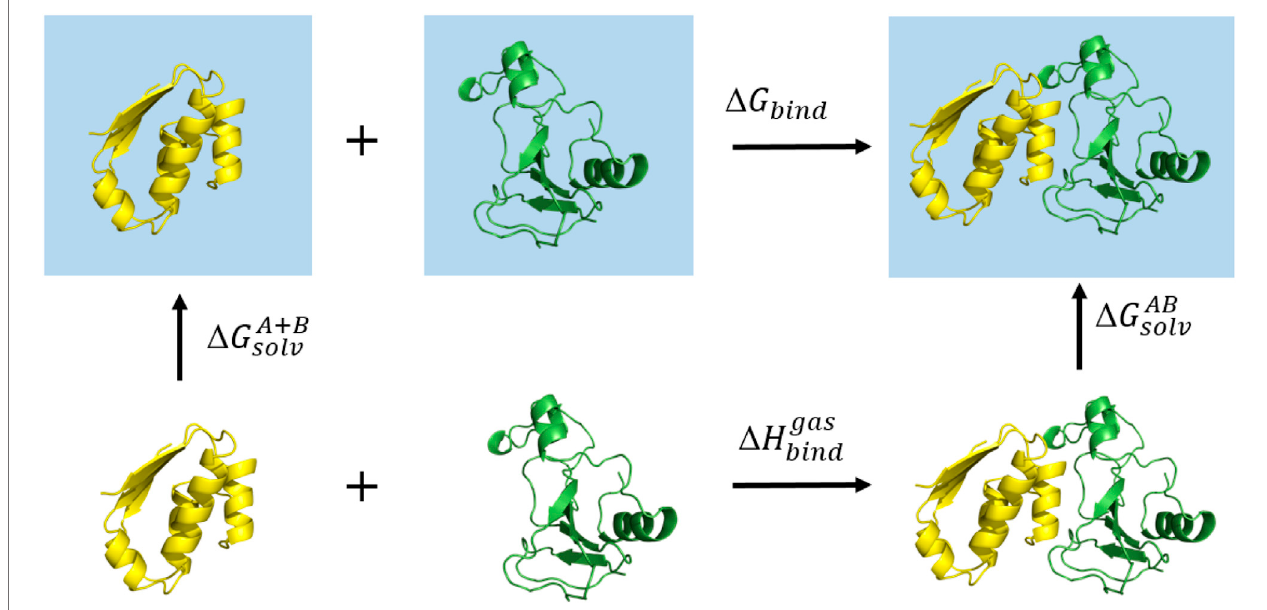
FIGURE 3 | The thermodynamic cycle used in the MM/GBMV calculation. The square blue surface represents the water solvent.